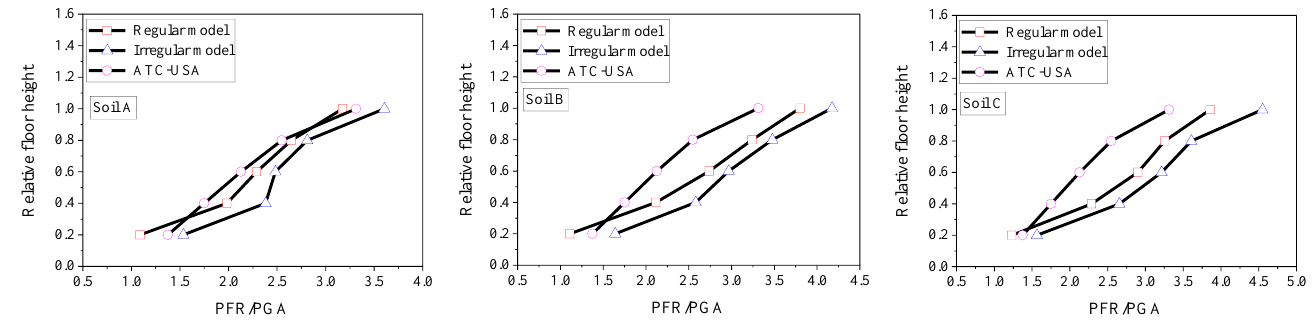
Figure 11. Comparison of floor amplification factors between the considered building models and ATC-USA.